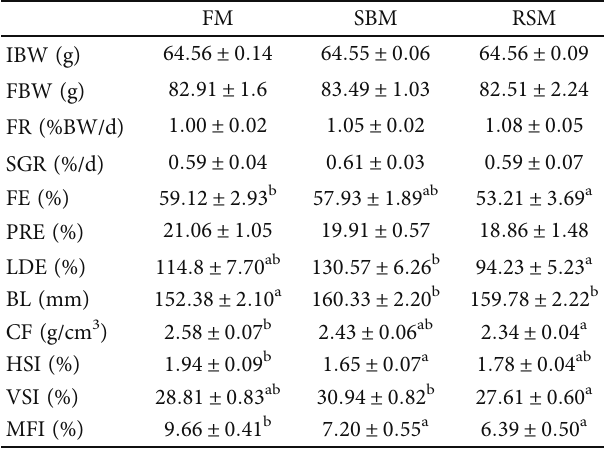
Table 5: Feed utilization and morphological parameters of female yellow cat fi sh broodstock fed the experimental